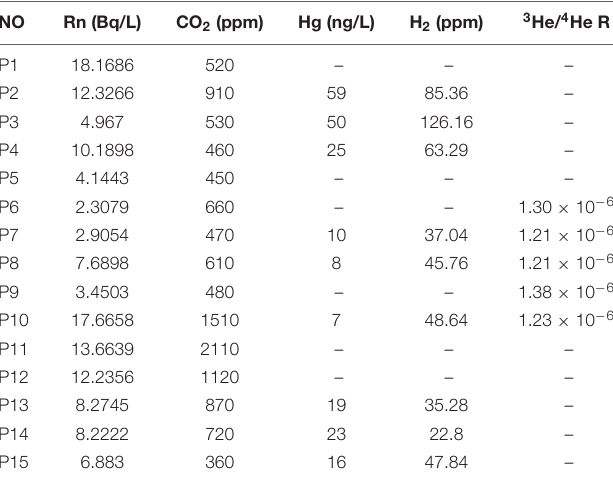
TABLE 2 | Main statistic parameters of soil gas data in study area.